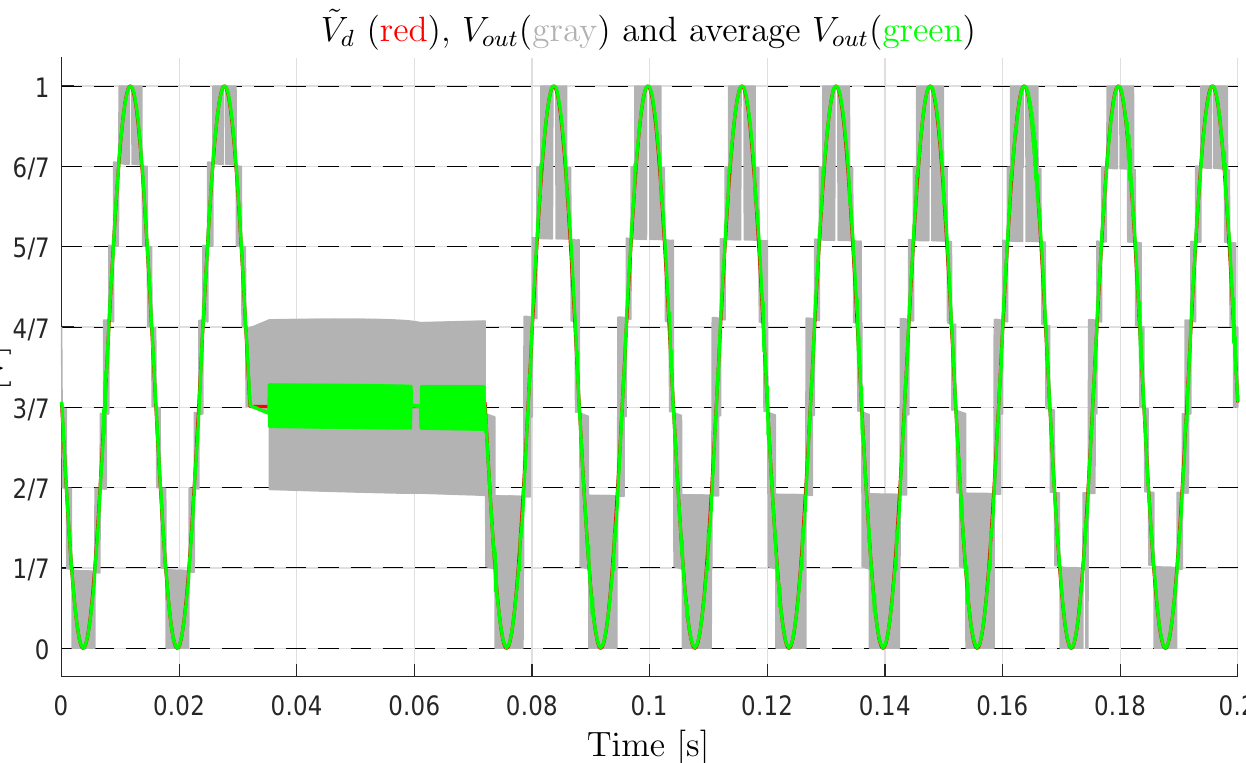
Figure 29. Non-Deformation of the output voltage waveform in the extended operation of the converter with the Configura- tion Voltage Vector V m = [ 7 6 2 ] T , in the presence of a constant output voltage, thanks to the Variable-Step